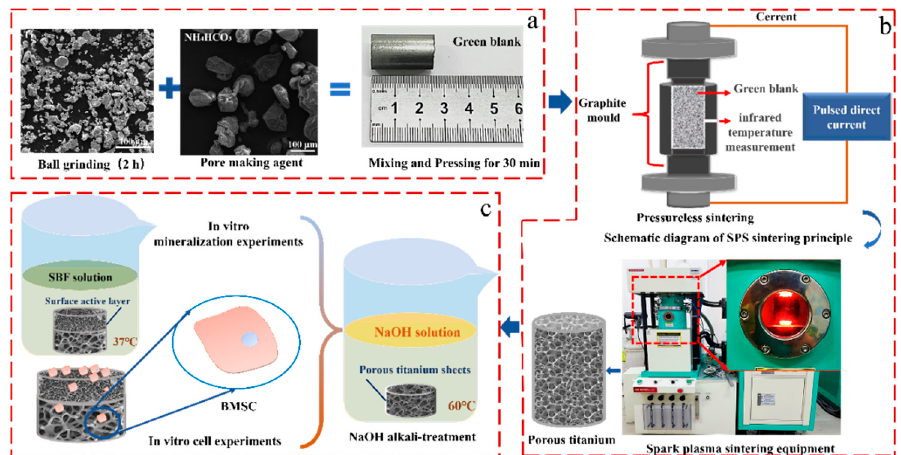
Figure 1. Experimental flow chart: ( a ) The Ti powder of ball milling for 2 h was mixed with NH 4 HCO 3 , and the blank was pressed for 30 min. ( b ) The blank formed by pressing was put into the sintering chamber of SPS sintering equipment, and porous titanium was sintered in one step for 10 min. ( c ) Sintered porous titanium was cut into round pieces and soaked in a high concentration of sodium hydroxide solution for 24 h for alkali treatment modification. The immersion temperature was maintained at 60 °C using a constant water bath. Finally, in vitro biological activity evaluation of alkali-treated porous titanium was carried out (in vitro mineralization experiment and cell proliferation and live dead cell staining experiment of bone marrow stem cells).